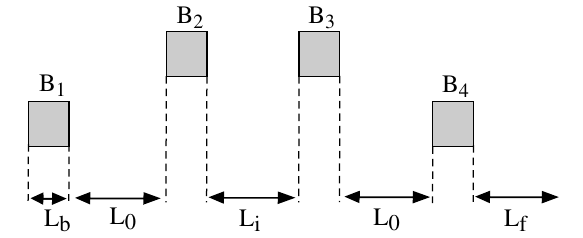
FIG. 8. Layout of the four bends test chicane considered for code benchmarking.